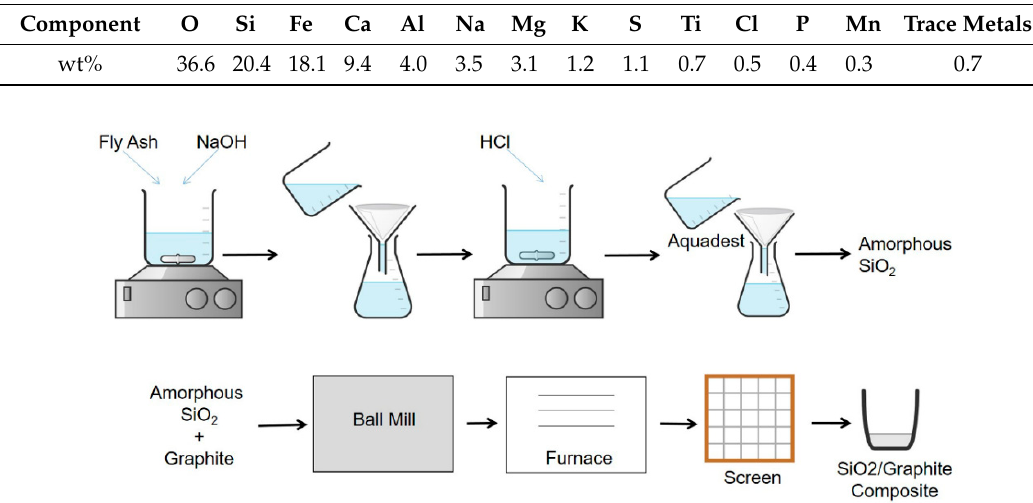
Table 1. XRF analysis of coal combustion-derived fly ash from PT Semen Indonesia.